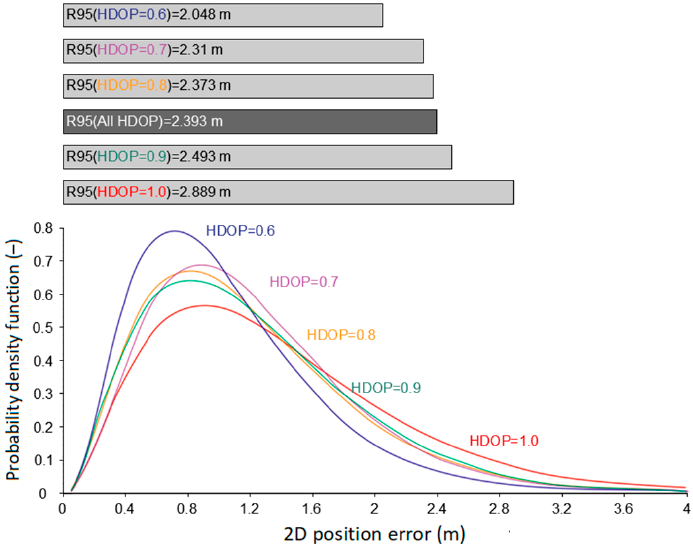
Figure 9. The relationship between the HDOP value and the GPS position error [8].